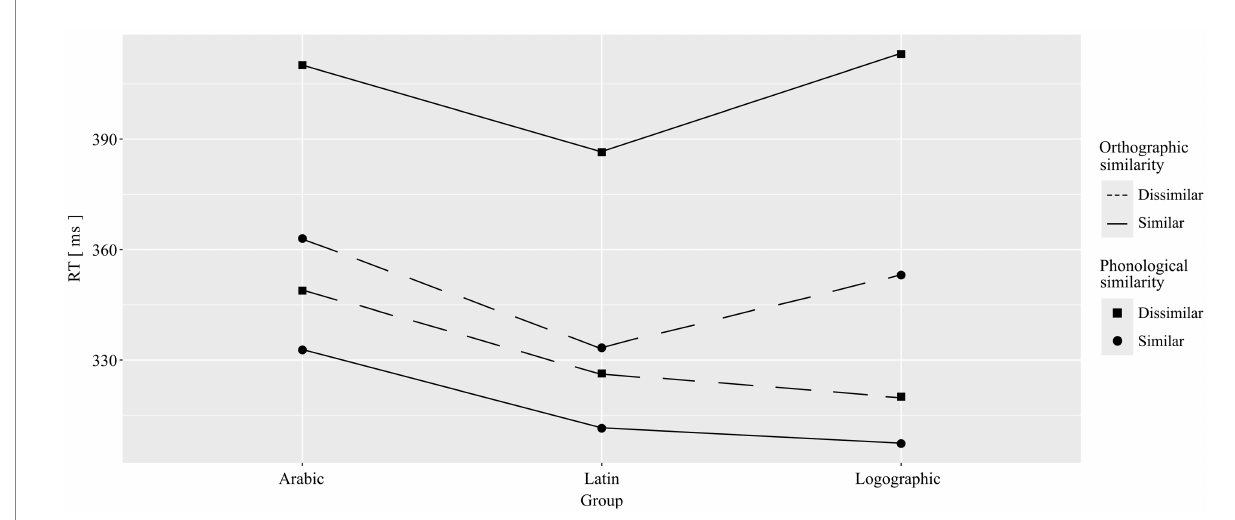
FIGURE 3 Effects of group, phonological similarity, and orthographic similarity on reaction time (ms).